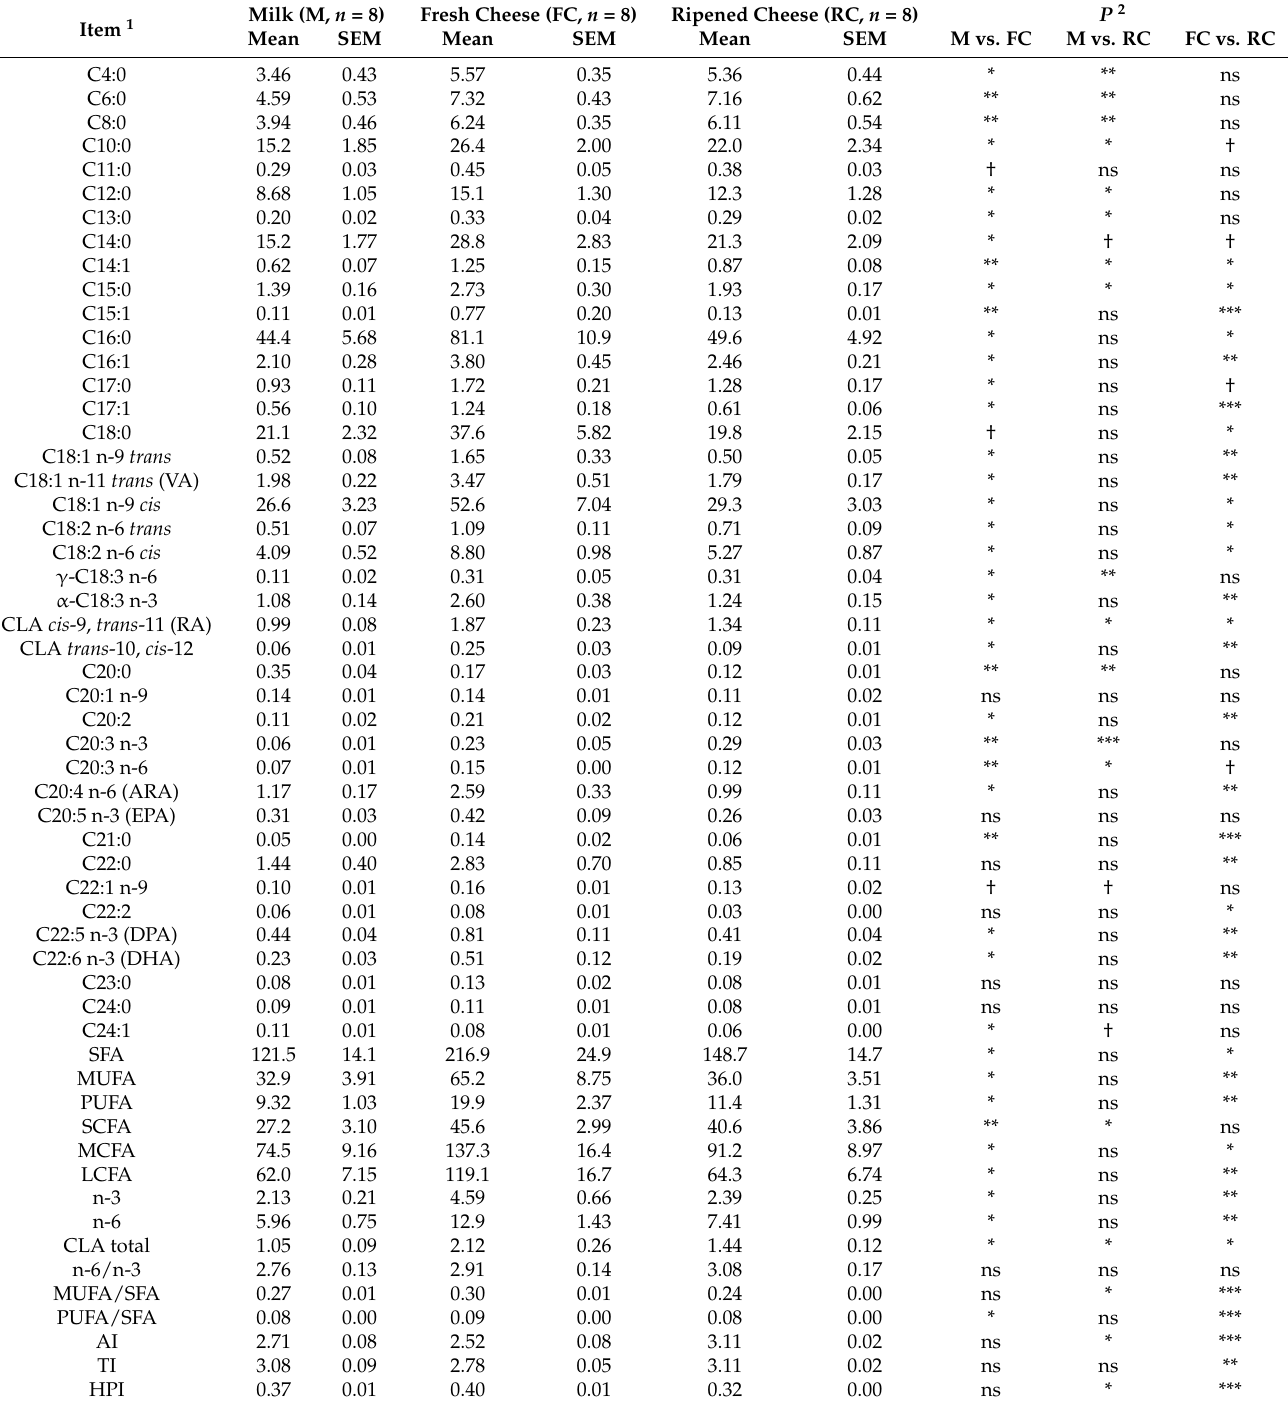
Table 4. Fatty acid (FA) content (expressed as mg/g dry matter (DM)) of fresh and ripened Roja Mallorquina ewes’ cheese and corresponding original